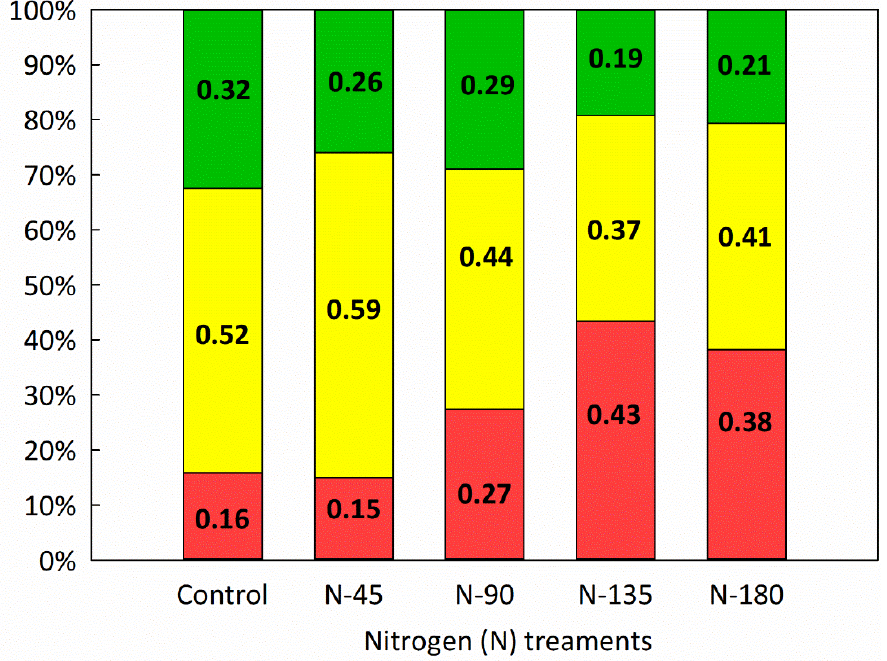
Figure 3. Stoplight chart for profit probabilities of less than $100 ha −1 and greater than $1000 ha −1 for DP 1646. The probabilities of achieving favorable, unfavorable, and questionable outcomes are represented by green, red, and yellow color, respectively.